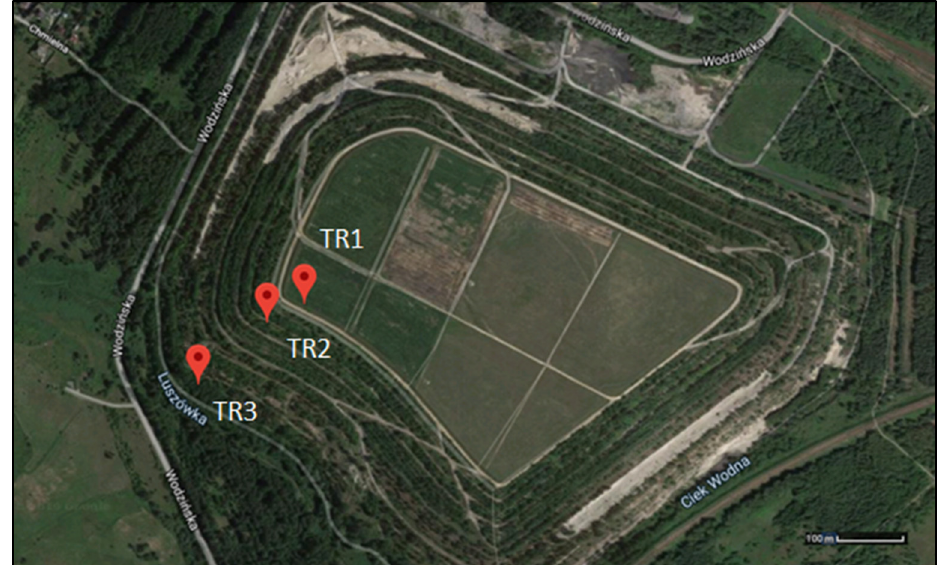
Figure 1. Location of profiles TR1, TR2, TR3 on the mine tailing disposal site of the abandoned mine of Zn and Pb ores “Trzebionka” in Trzebinia (www.google.pl/maps, accessed on 12 April 2021).